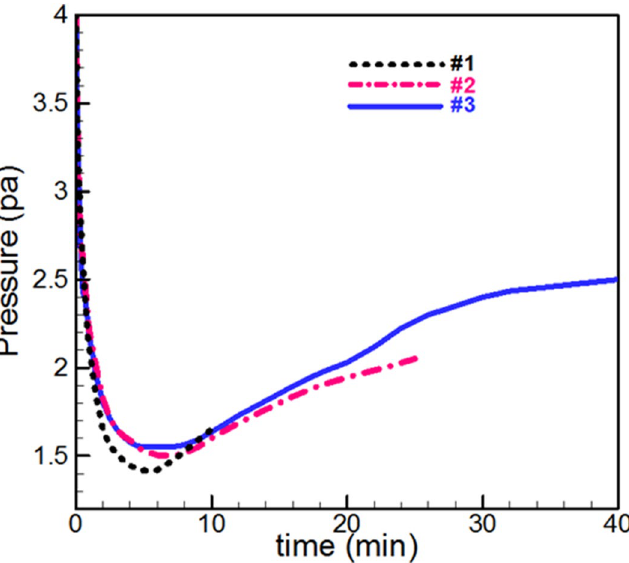
Figure 1. Deposition pressure diagram of the chamber (Pa) versus time of deposition (min) for samples #1 to #3.